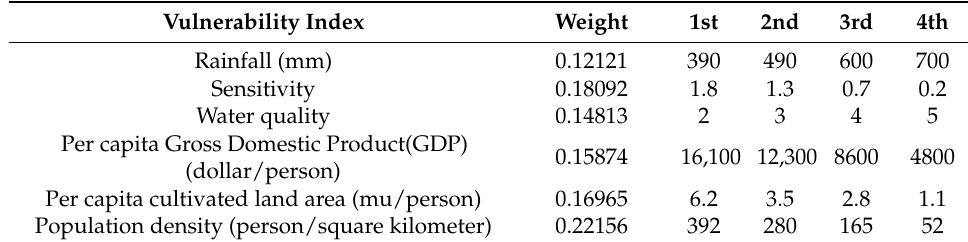
Table 5. Vulnerability index classification standard and weight table.